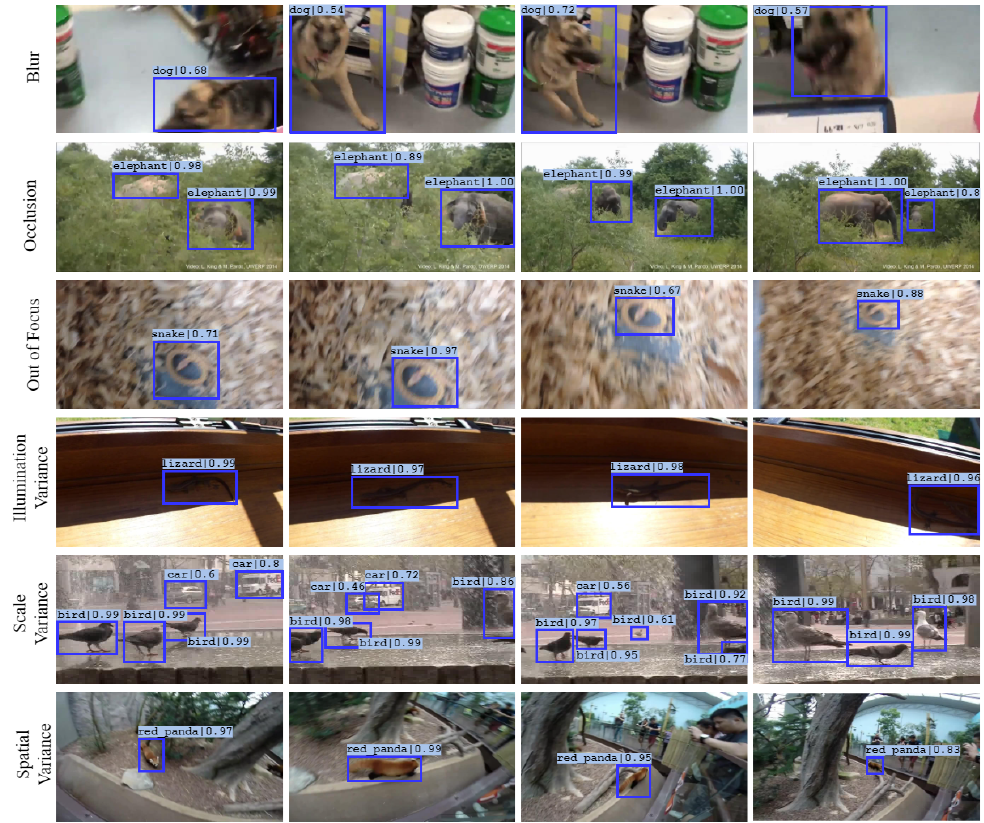
Figure 8. Video object detection under challenging conditions. The figure demonstrates the robustness of the proposed approach against inherent challenges in